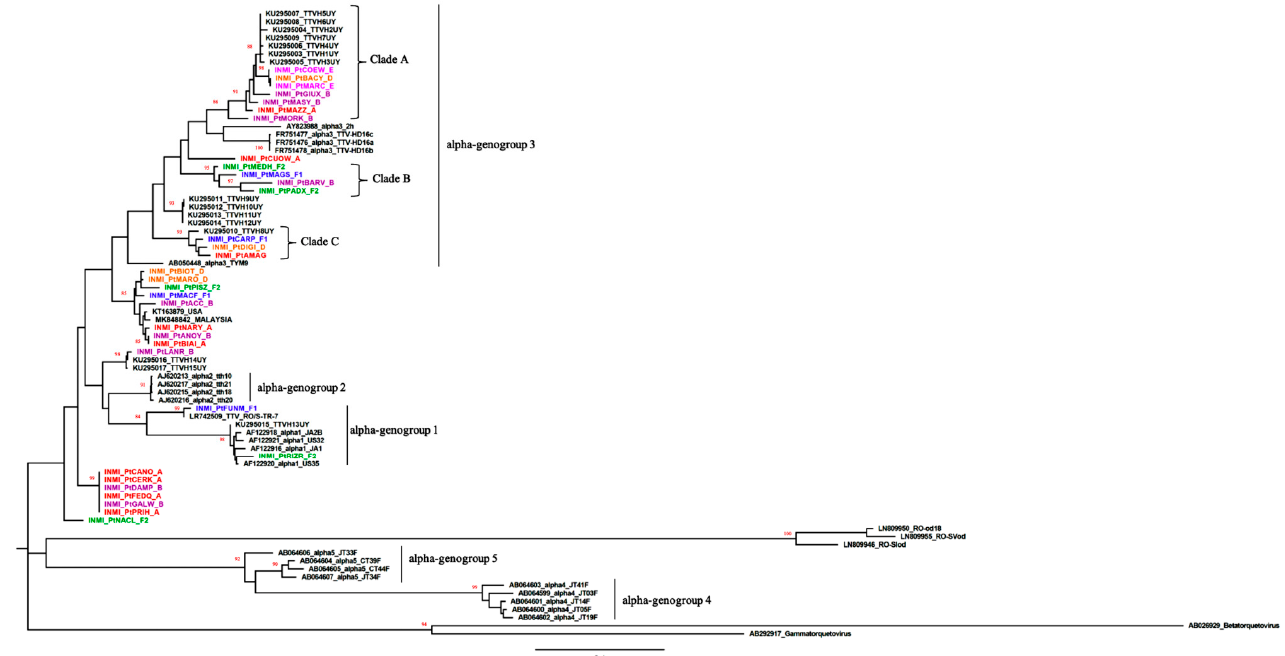
Figure 1. Phylogenetic analysis of TTV UTR B (3 ′ UTR) region from patient-derived samples. Thirty-three patient-derived nucleotide sequences and representative TTV genogroup sequences, chosen following the original publications [8,14,41,45,46] and ICVT [47] were used for the construction of a Maximum-likelihood method tree that was visualized with Fig Tree (Available online: http://tree.bio.ed.ac.uk/software/figtree/ (accessed on 22 December 2020)). Bootstrap values >80% are indicated on respective branches. Scale bar represents nucleotide substitutions per site. TTV Italian strains were indicated as INMI. Patients included in group A are in red, in group B in violet, group D in orange, group E in pink, group F1 in blue, and group F2 in green. Reference sequences are indicated by their GenBank accession number, genogroup, and name of the isolate if available.The list of all GenBank accession numbers is reported in Supplemental Materials Tables S1 and S2.